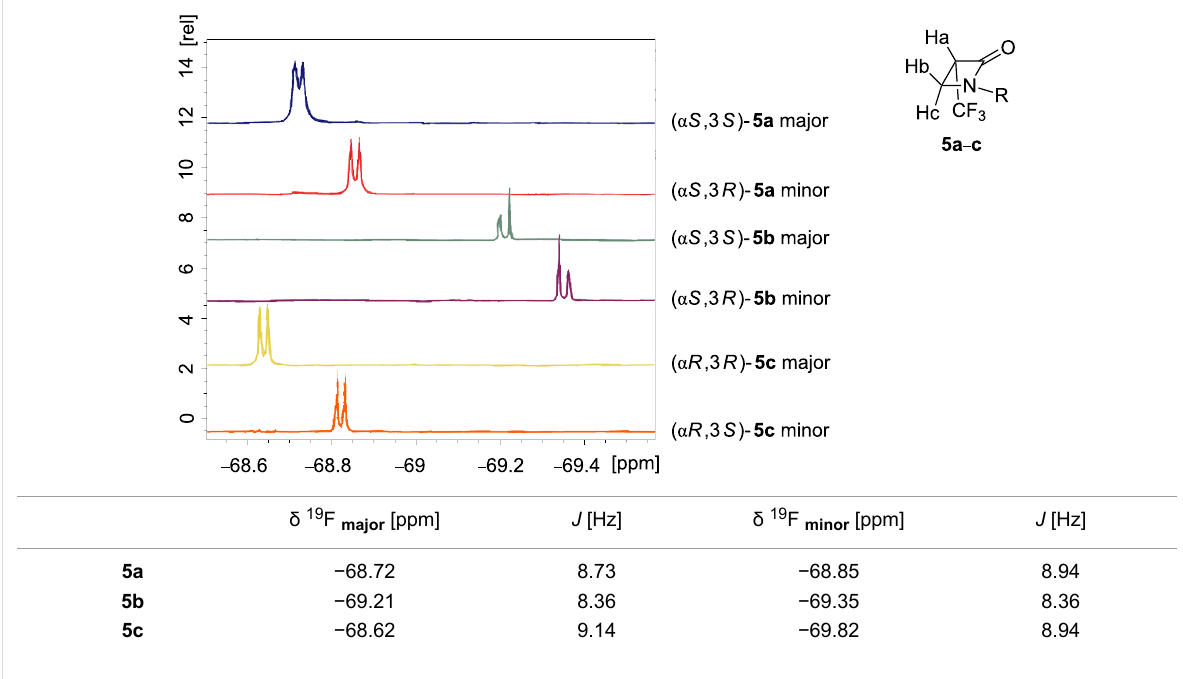
Table 2: Comparison of the 19 F NMR chemical shifts of the diastereoisomers of 5a – c .